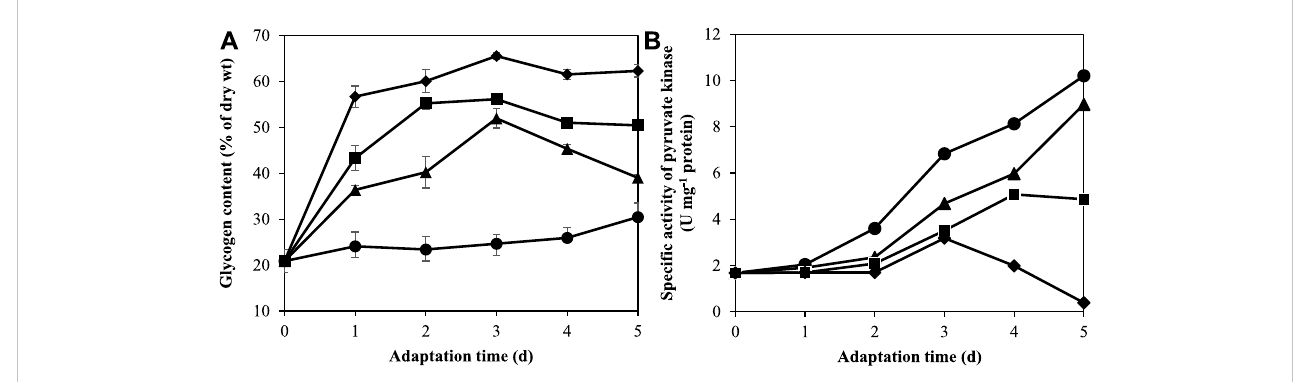
FIGURE 3 Effectofadaptationtimeonglycogencontent (A) andspeci fi cactivityofpyruvatekinase (B) by A.halophytica cells. A.halophytica wasadaptedinvarious (cid:129) kinds of media for various times, BG11 ( ), BG11 0 ( ▲ ), BG11-K ( ■ ), and BG11 0 -K ( ⬧ ) for 1 – 5 days before harvesting and resuspending in a fresh medium. H 2 production was measured in incubated cells under dark anaerobic condition for 24 h. Data are means ± SD ( n =